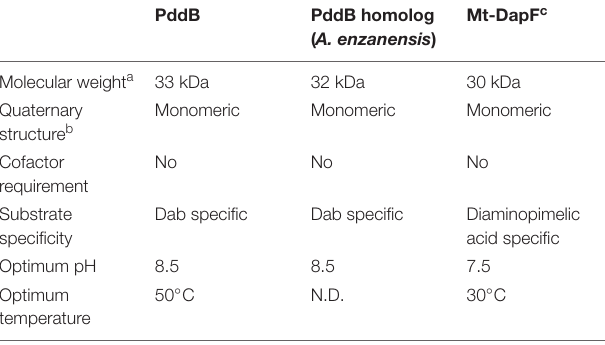
TABLE 3 | Comparison of enzymological properties between DabRs and